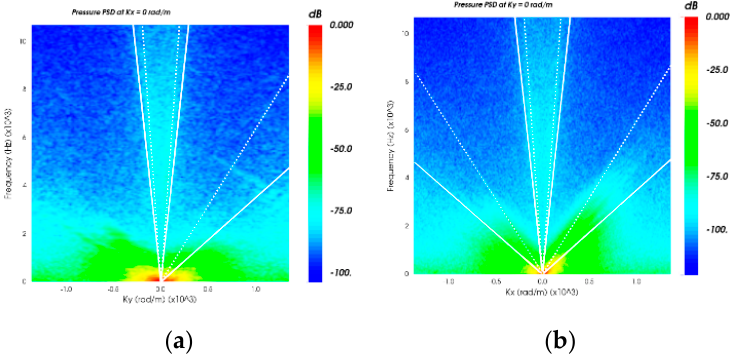
Figure 23. WFS in the X and Y directions of the panel: ( a ) (cid:1863) (cid:3051) = 0 rad/m ; ( b ) (cid:1863) (cid:3052) = 0 rad/m .